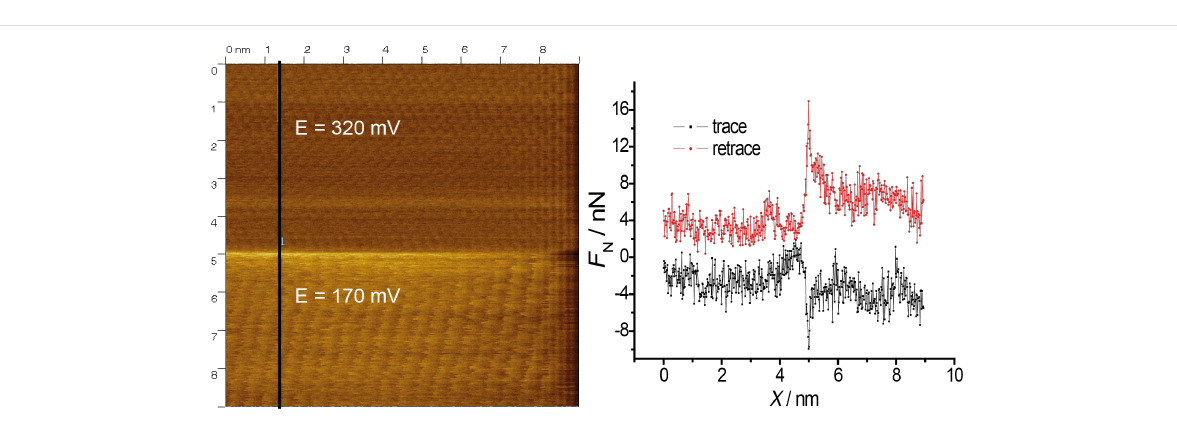
observed. A similar effect was observed by Meyer and coworkers [33]: Upon an increase in normal load on a NaCl(001) surface a transition to multiple slip was